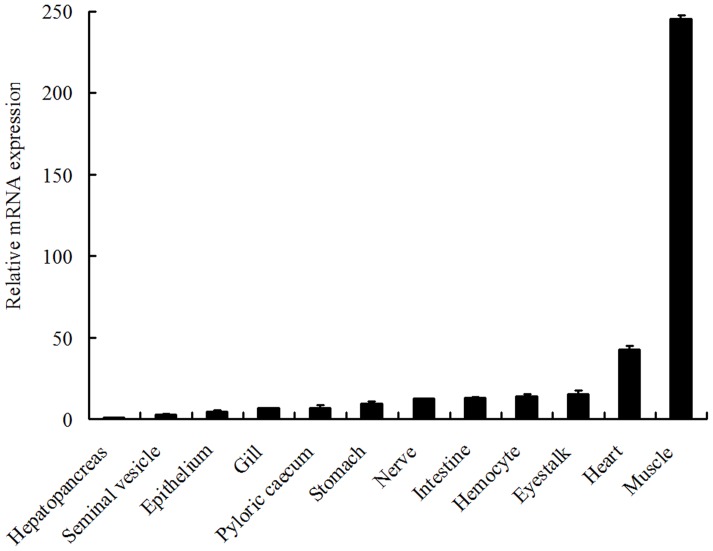
Tissue distributions of LvLRRFIP2s in healthy L. vannamei.Ten animals were used for tissue sampling. LvEF1α was used as the internal control to normalize the cDNA template used for real-time PCR analysis.